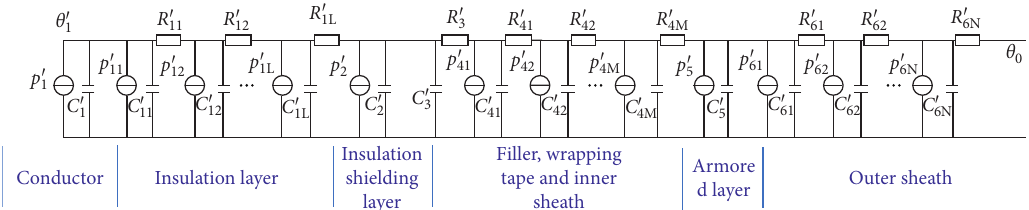
Figure 8: Layered trisection transient thermal circuit model of power cable.